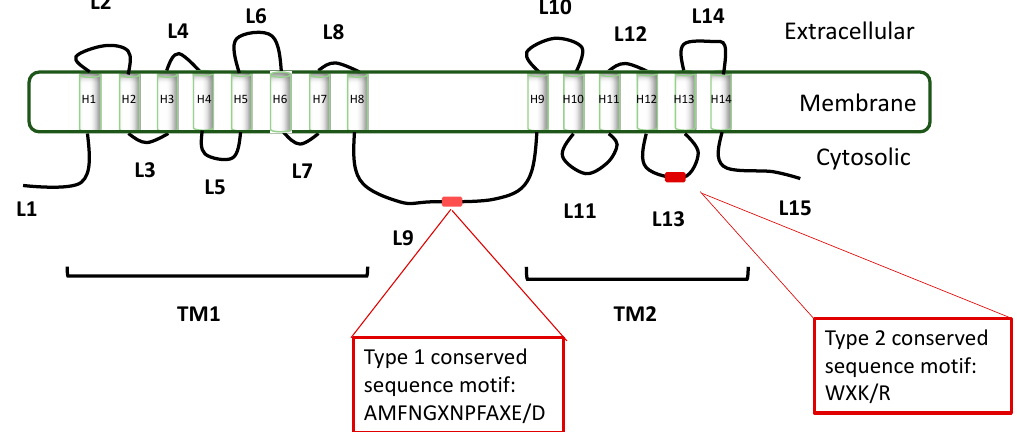
Figure 4. Diagram of the predicted topology of β -glucan synthase, based on Basidiomycetes sequence predictions. Extra- and intracellular loops are numbered L1–L15. α -helices, corresponding to transmembrane domains (TM1, TM2) are numbered H1–H14. Type 1 and 2 signal sequence motifs are also shown [44,72].